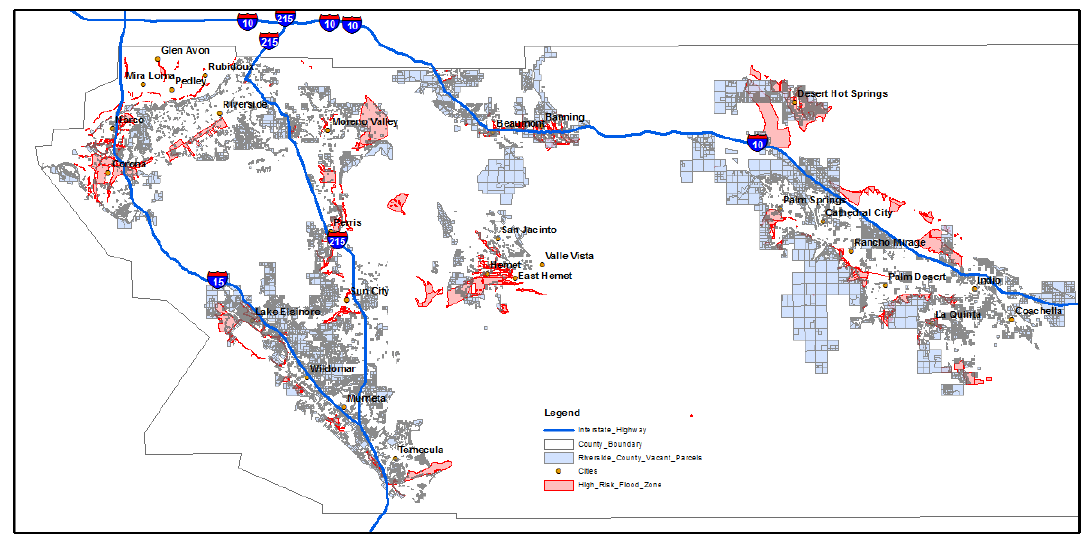
Figure 1. Distribution of vacant land and high-risk flood zones of Riverside County in the greater LA